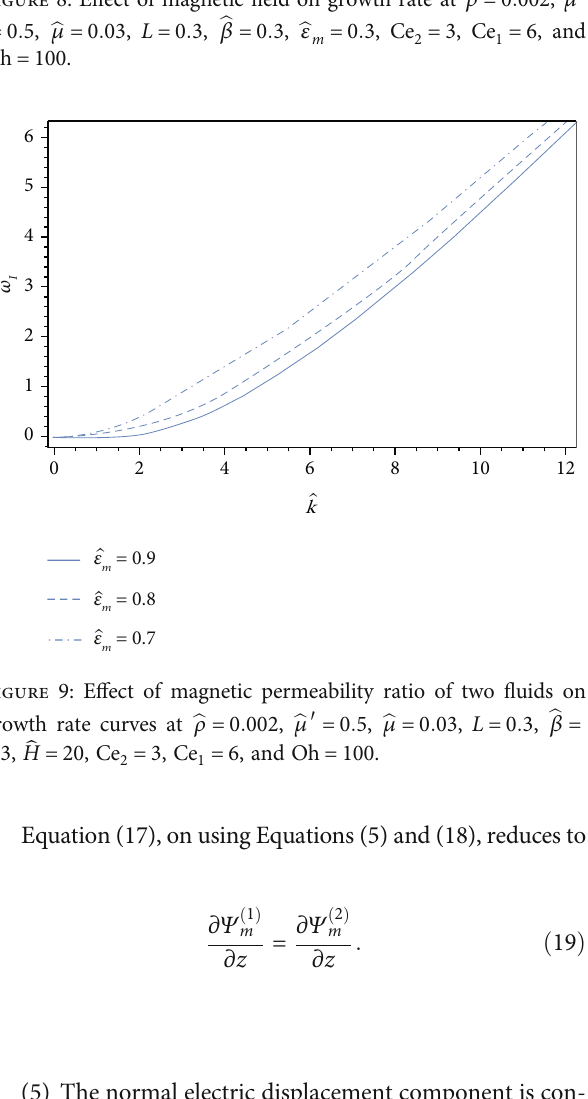
= 0 : 3 , Ce = 3 , Ce = 6 , and m 2 1